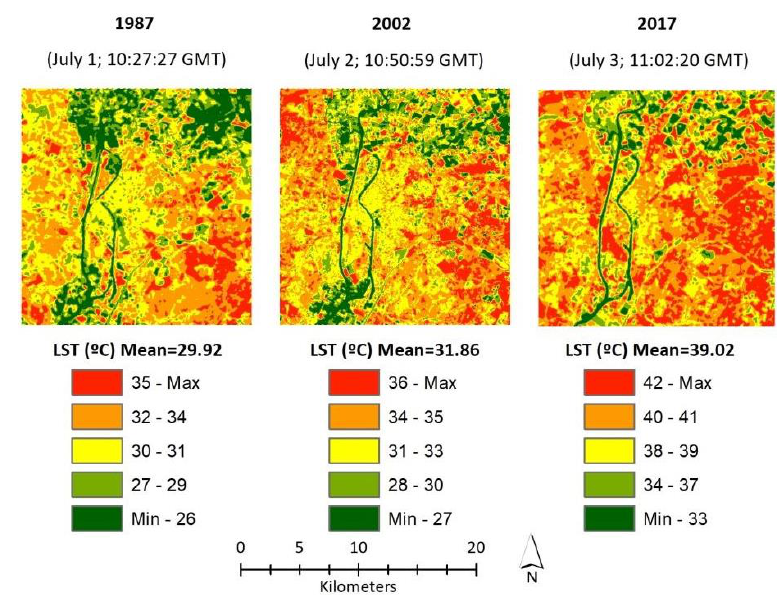
Figure 4. Land surface temperature (LST) maps; Seville City and its immediate surrounding areas derived from Landsat imagery (1987, 2002 and 2017).